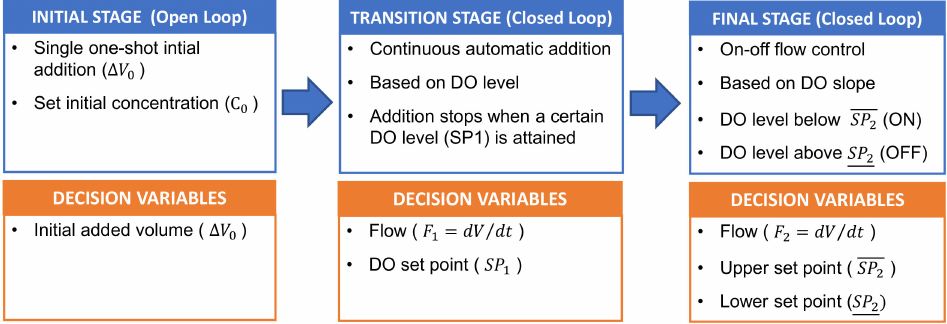
Figure 1. Scheme illustration of the H 2 O 2 dosage scheme: Initial addition, Constant flow and On-Off